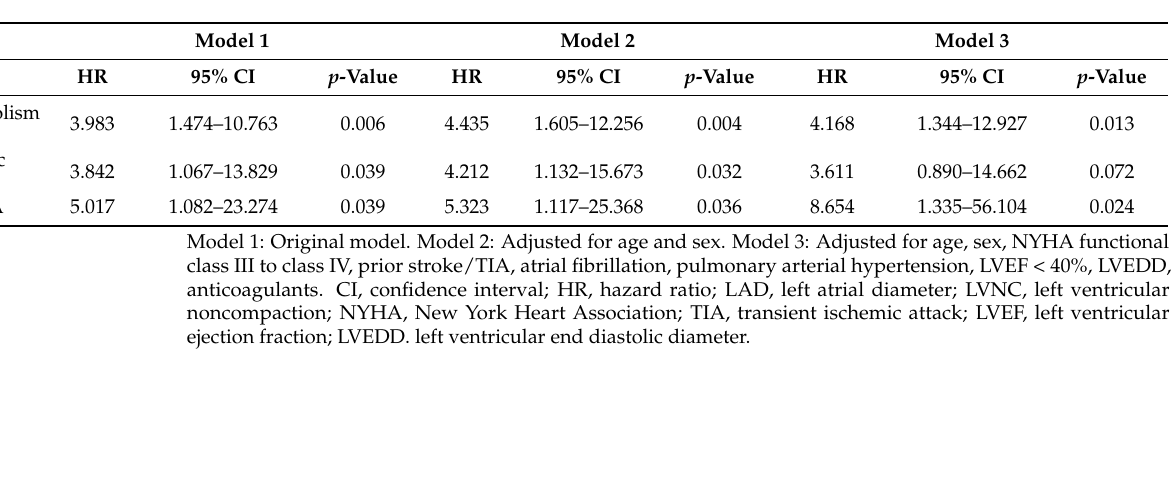
Table 3. Association between left atrial diameter ≥ 43 mm and endpoints in patients with left